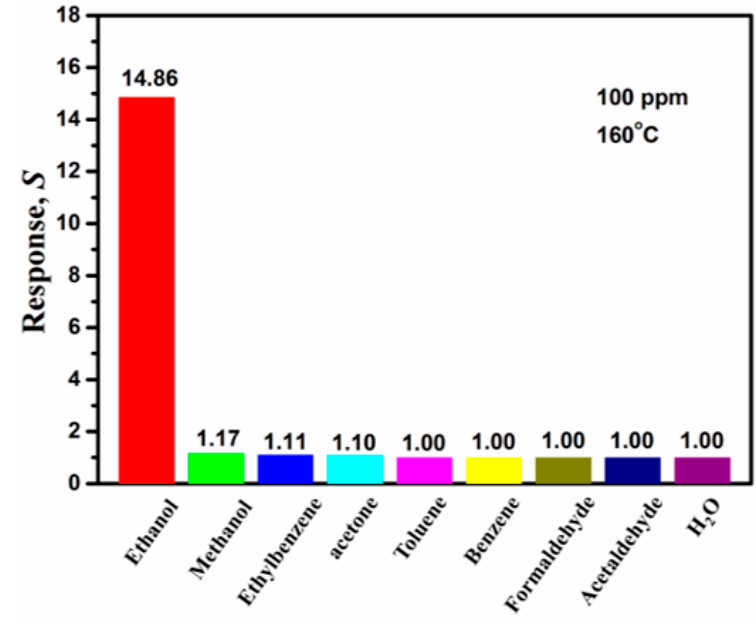
Figure 11. The response S towards various test gases at 100 ppm of SnS nanosheets at an operating temperature of 160 °C.